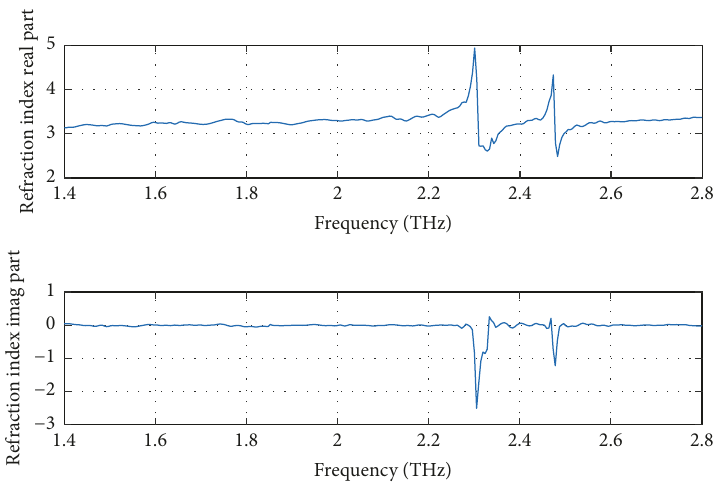
Figure 14: The refraction index calculated from the scattering parameters.